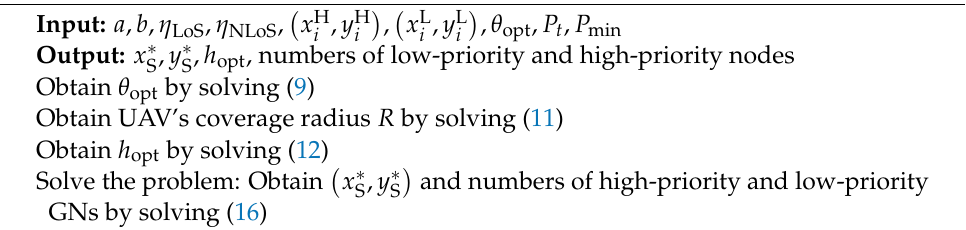
Algorithm 1: Obtain optimal 3D position